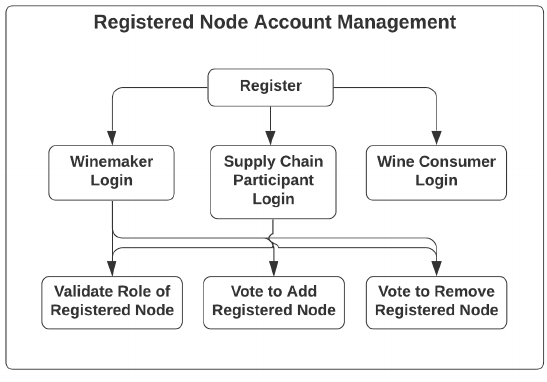
Figure 7. Use Case of Registered Node